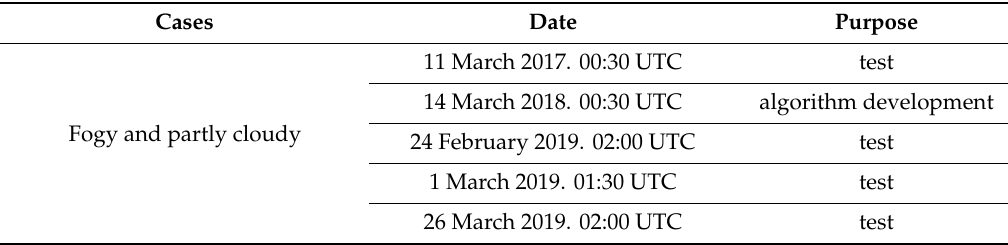
Table 2. Cases including sea fog used in this